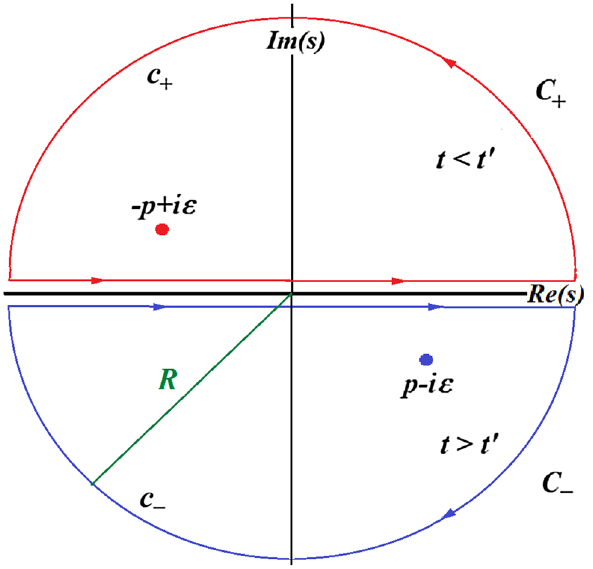
Fig. 1 The contours of integration in the complex s -plane, C ± , are the limits of the pictured ones for R →